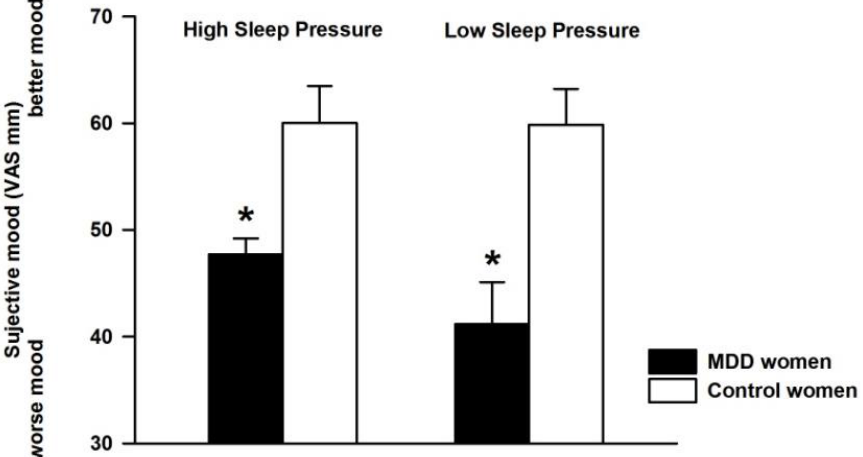
Figure 1. Subjective mood (Visual Analogue Scale—VAS) averaged for controls (white bars, n = 8) and major depressive disorder (MDD) women (black bars, n = 8) for high (left panel) and low sleep pressure (right panel). Data are presented as mean values ± standard error of the mean (SEM). * p < 0.05.